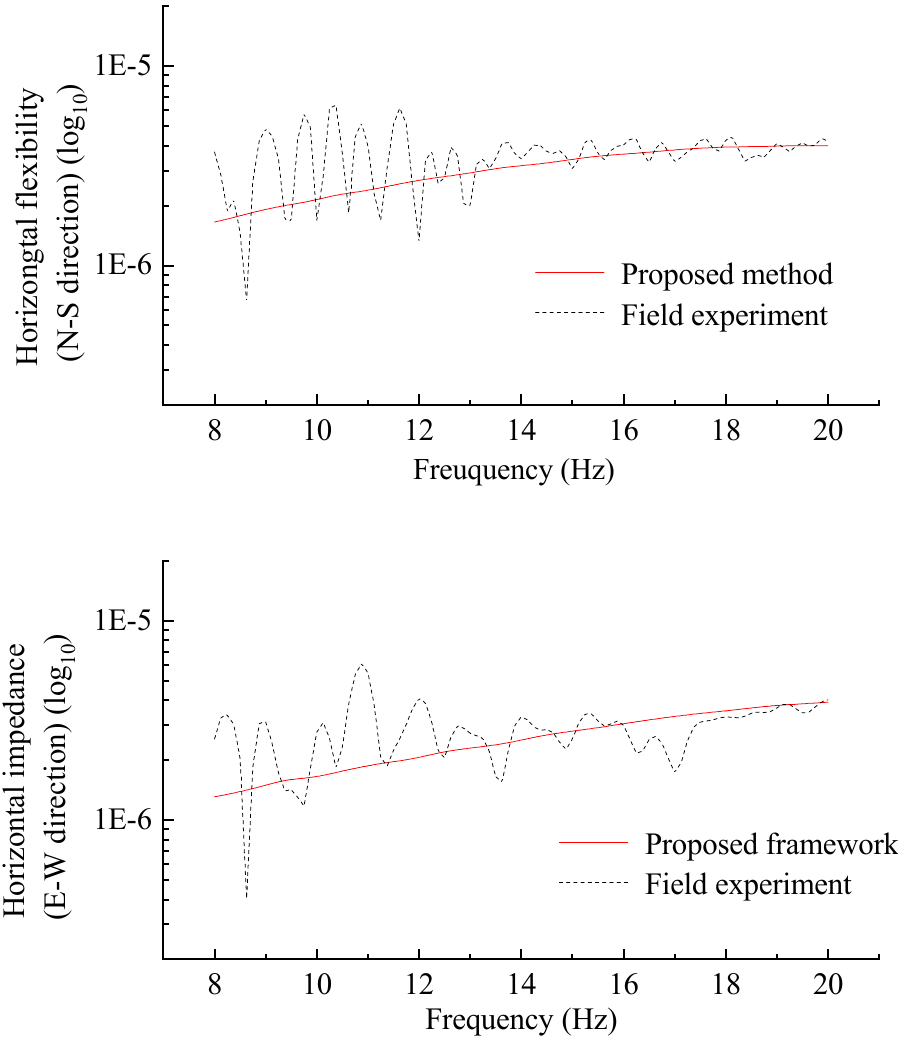
Figure 11. Dynamic flexibility obtained by the proposed algorithm and the field experiment.